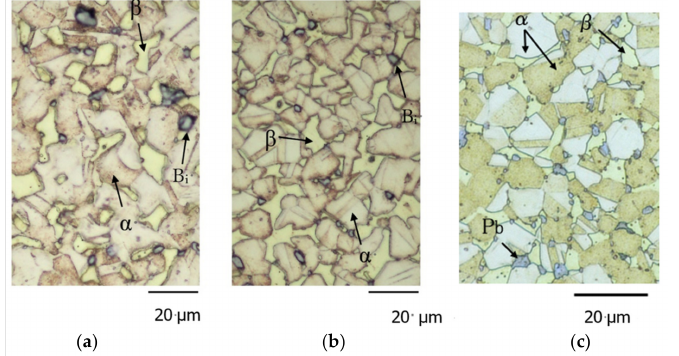
Figure 1. Microscopic structure of the materials used in this study: ( a ) Bi, A ; ( b ) Bi, B ; ( c )